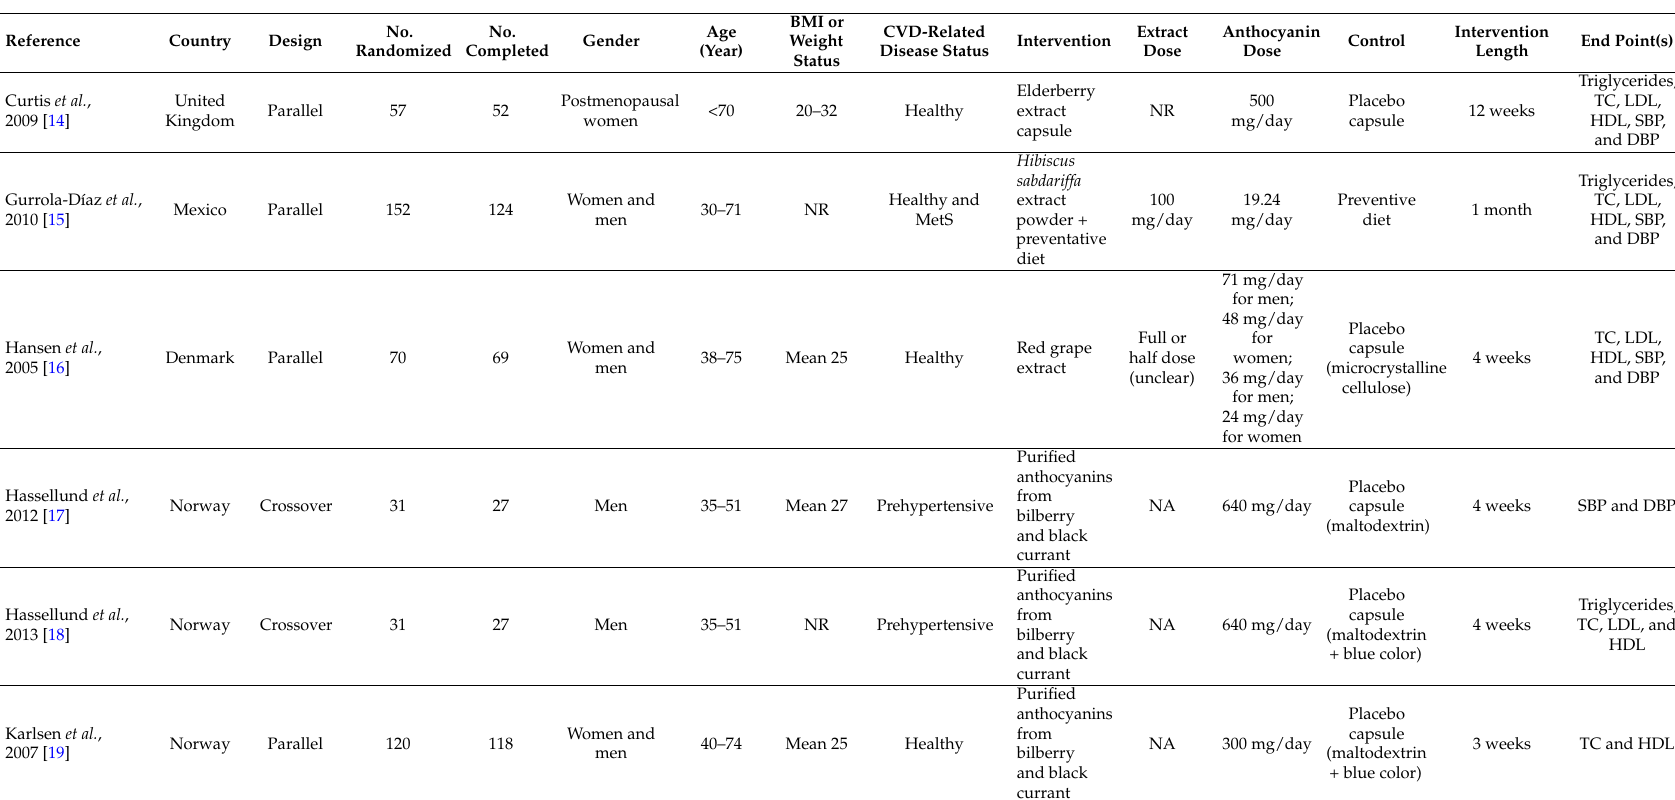
Table 1. Study characteristics 1